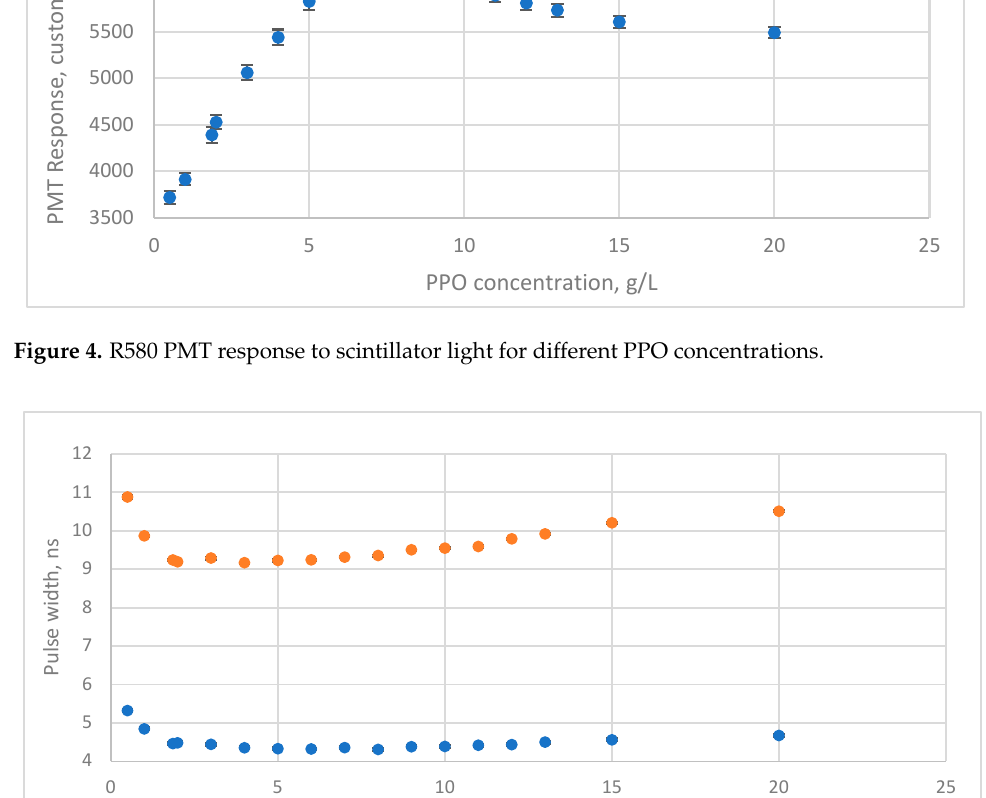
Figure 4. R580 PMT response to scintillator light for different PPO concentrations.